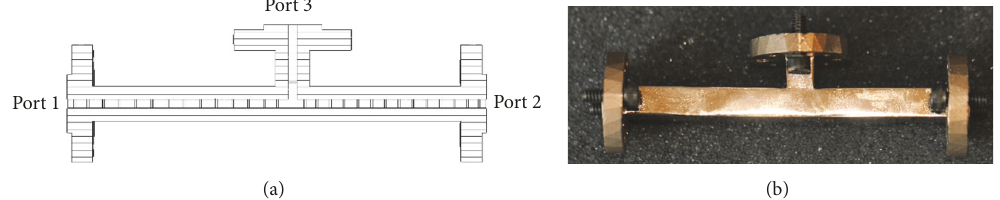
Figure 6: 3D printed E-band diplexer: (a) perspective view and (b)